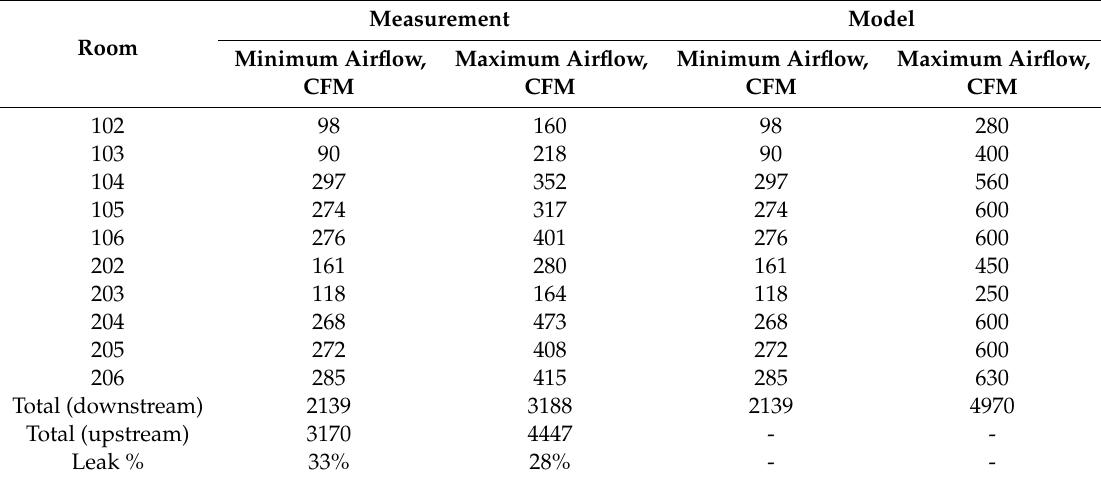
Table 2. Airflow measurements for supply air duct leakage